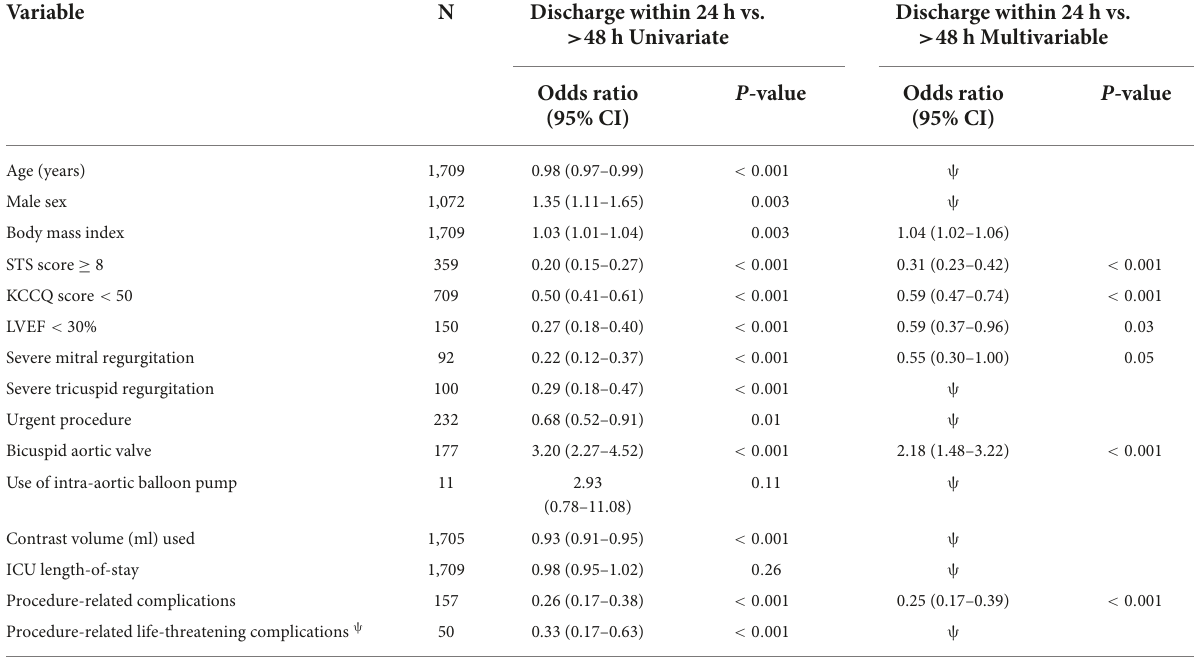
TABLE 4 Univariate and multivariable analyses of discharge within 24 h (vs. > 48